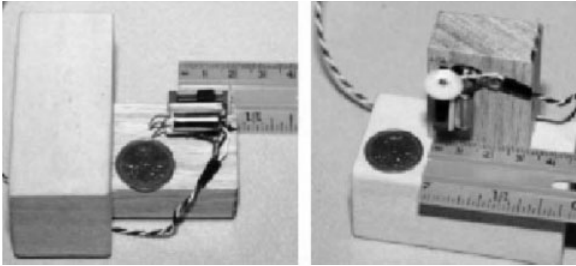
Figure 9 Light servomotor is compared with a penny.